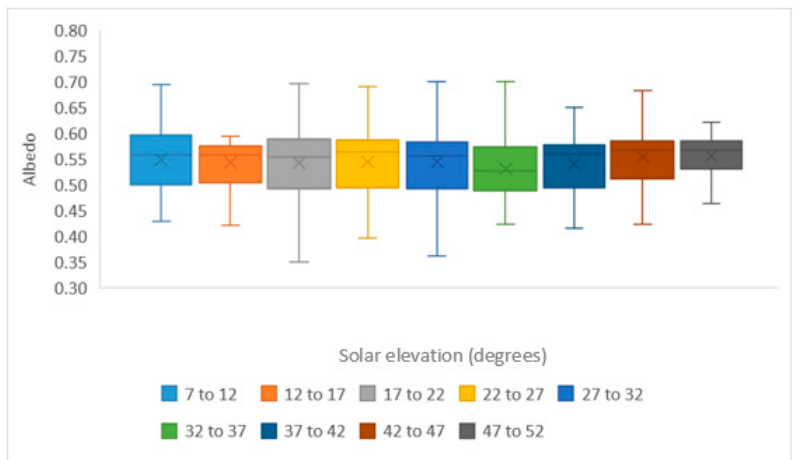
Figure 5. White pebbles’ overcast (OV) sky condition for albedo variation against solar elevation. The 11 ranges of solar elevation (degrees) are shown in the legend.